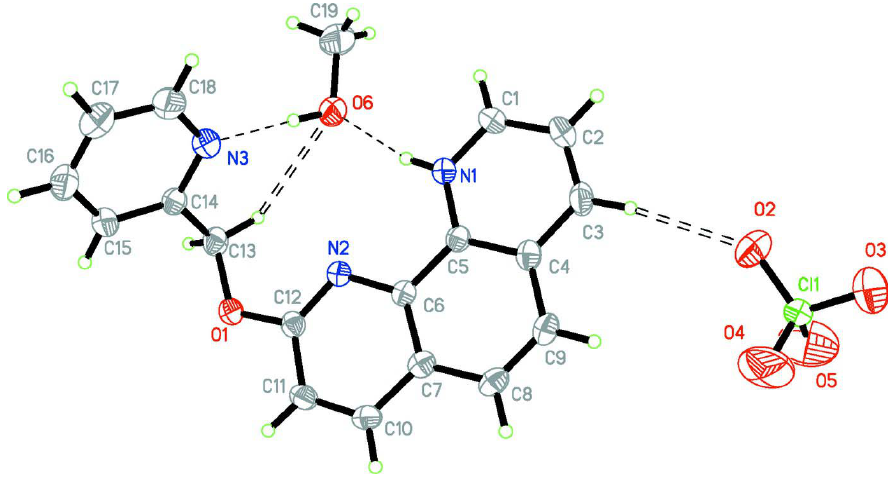
Figure 1 Structure of title organic salt with the atom-numbering scheme. Displacement ellipsoids are drawn at the 30% probability level. The classic hydrogen bonds are shown as dashed lines and non-classic hydrogen bonds as double dashed lines.